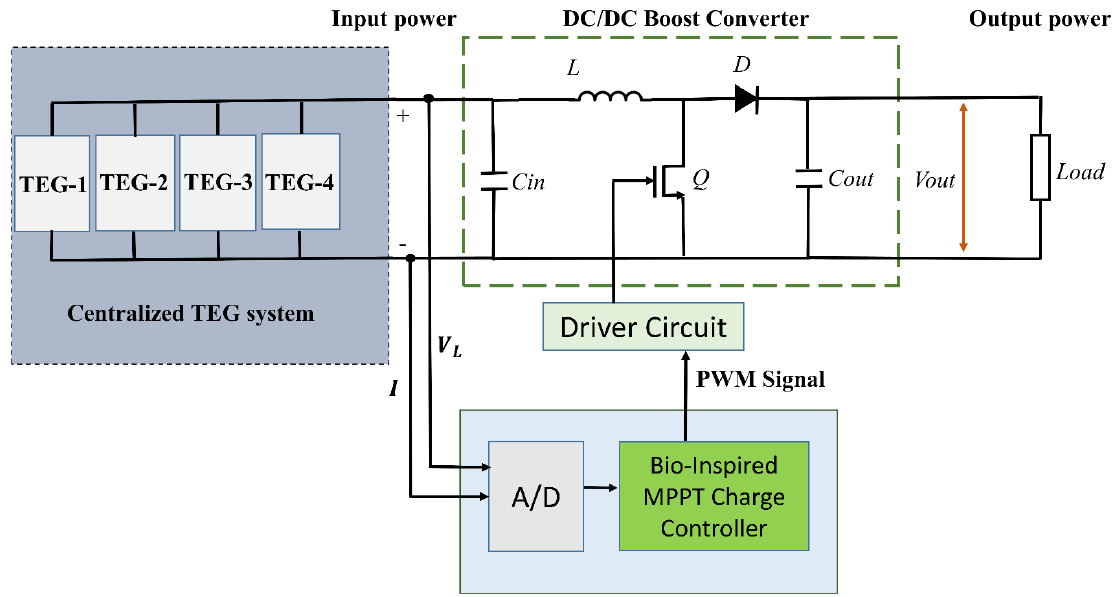
Figure 1. TEG modules interfaced with boost converter through MPPT